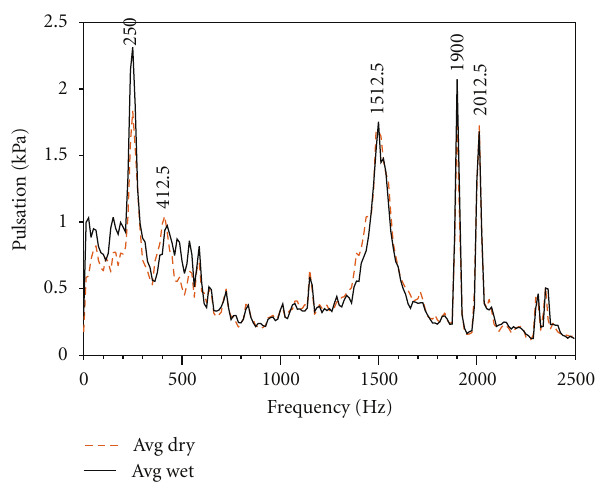
Figure 2: Pulsation comparison of the two water flow conditions at 100%